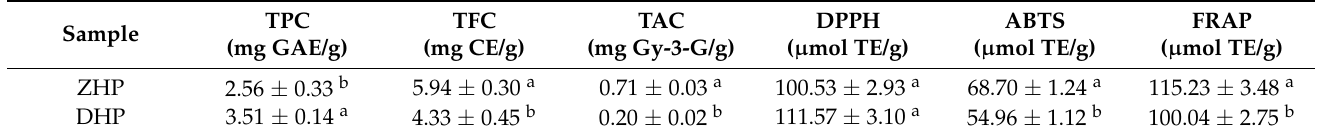
Table 1. TPC, TFC, TAC and antioxidant activity of ZHP and DHP.